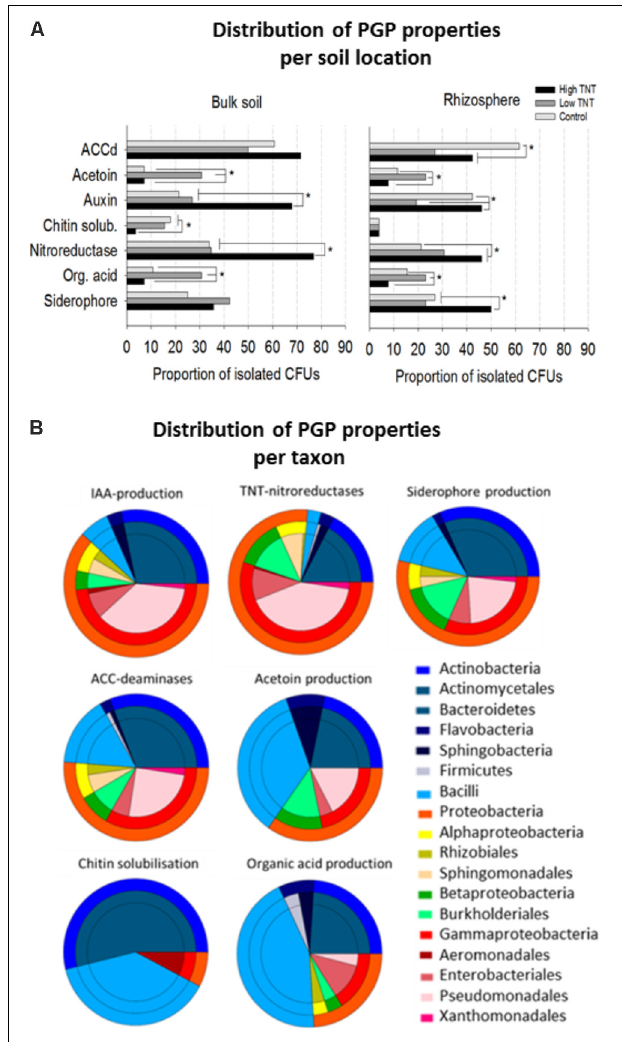
FIGURE 4 | Proportion of bacterial isolates with plant growth-promoting features, nitroreductase activity and their distribution according to origin (A) . Comparison of the proportions of bacterial isolates exhibiting in vitro PGP-activities and nitroreductase activity. For each assay, all the cultivable isolates per library were tested. Significant differences in activities are marked with an asterisk (Fisher’s exact test for pairwise comparisons and FDR correction, p < 0.05). (B) Pie diagrams showing the cumulative number of taxa with PGP and nitroreductase activity for each category as indicated above the pies. The outer rings represent the phyla and these are further broken down (inner rings) to the order level. For each test ( n = 10 bacterial isolates of the same genus were